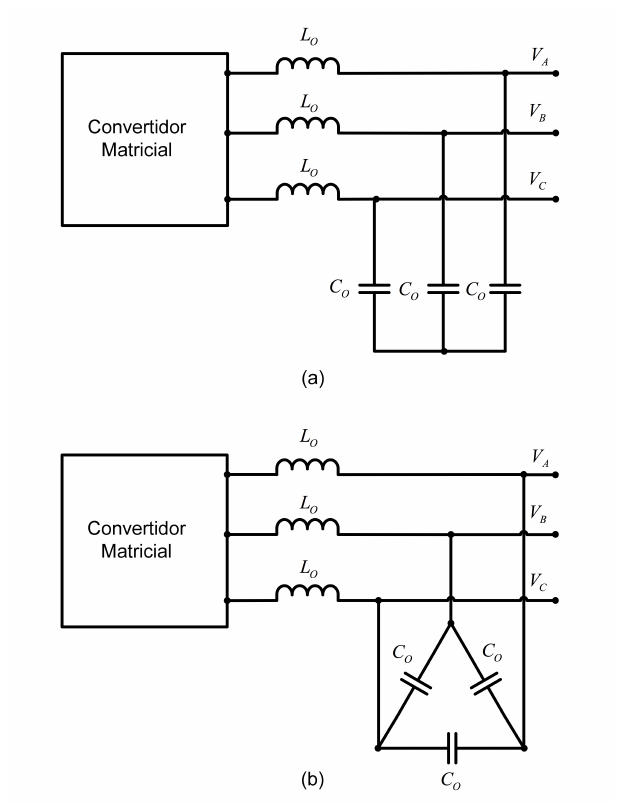
Figure 4. Topologies of filters LC for output stages: ( a ) star connection and ( b ) delta connection.